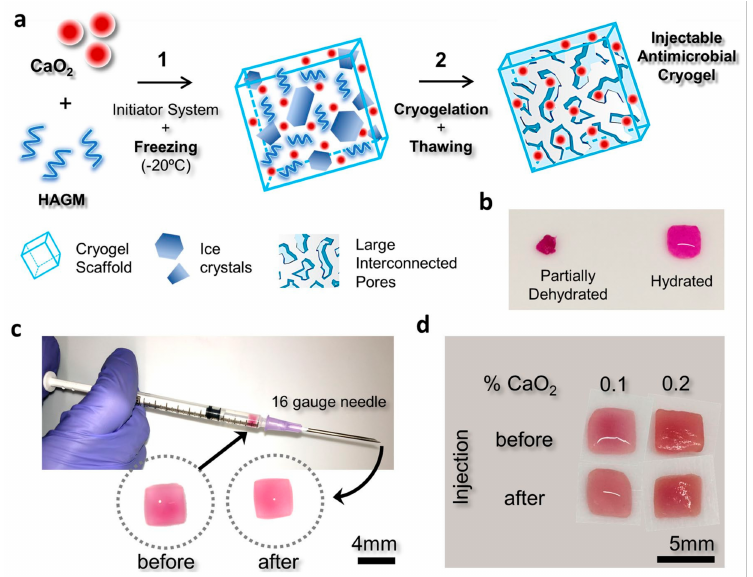
Figure 3. Schematic representation of the entire process involved in forming injectable cryogels: ( a ) the cryogelation procedure of microcomposite cryogels containing CP: (1) Cryogels were manu- factured using 4% HAGM with different amounts of CP (0–0.2% CaO 2 ); an initiator system is added to an aqueous HAGM solution, and then cryopolymerization is performed at − 20 ◦ C. (2) Ice crystal formation and gelation occurs. With the thawing of the ice crystals, an interconnected macroporous cryogel is formed. ( b ) dehydrated and hydrated forms of the obtained cryogels, ( c ) pre- and post- injection cryogel forms from a 16 G hypodermic needle, and ( d ) cryogels conserve encapsulated CP after injection